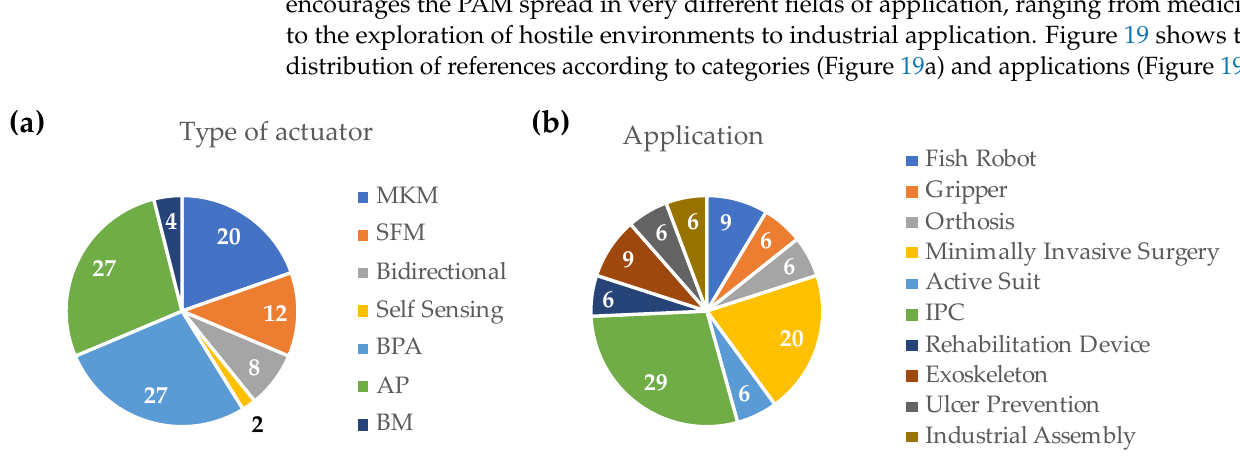
21 of 26 Figure 18. ( a ) The frequency of publication over the years; ( b ) The frequency of model description. The values are expressed in percentages. Despite this, PAMs have many advantages that make them preferable to other types of deformable actuators. They are low cost, have a high power/weight ratio, and are easy to install. Thanks to the constitutive material flexibility, it is also possible to produce very different shapes and sizes. Seven different PAM categories have been identified in this review: McKibben muscles (MKM); straight fiber muscles (SFM); bidirectional linear ac- tuators; self-sensing actuators; bending pneumatic actuators (BPA); air-pocket (AP); bel- low muscles (BM). Regardless of the category, the actuators are generally manufactured in silicone ma- terials through the casting-in-mold technique. Textile pneumatic actuators are a recent alternative. They can easily integrate into active suits and are particularly suitable for ap-